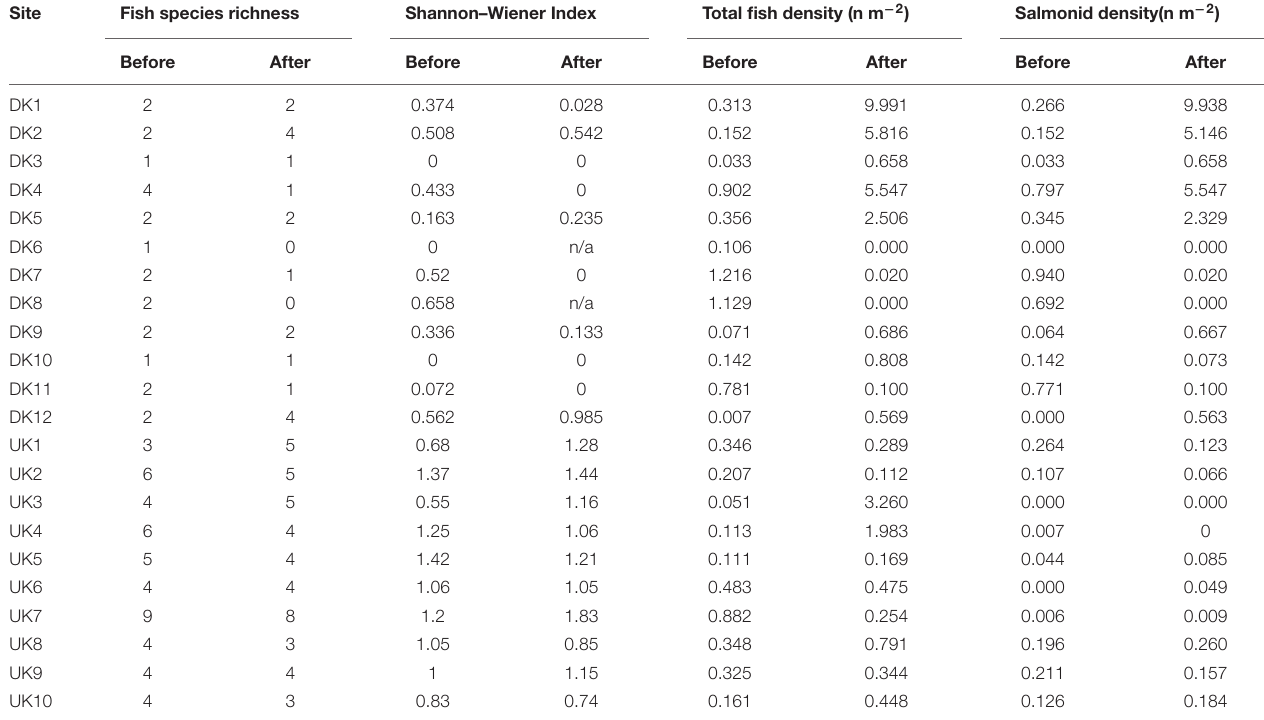
TABLE 2 | Fish species richness, Shannon–Wiener Index, total fish density, and salmonid density recorded before and after barrier removal. Site Fish species